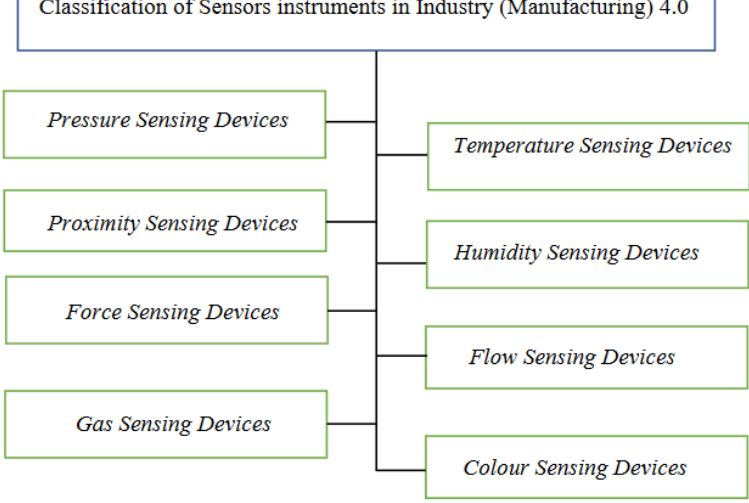
Figure 18. Classification of the sensors in Industry 4.0.